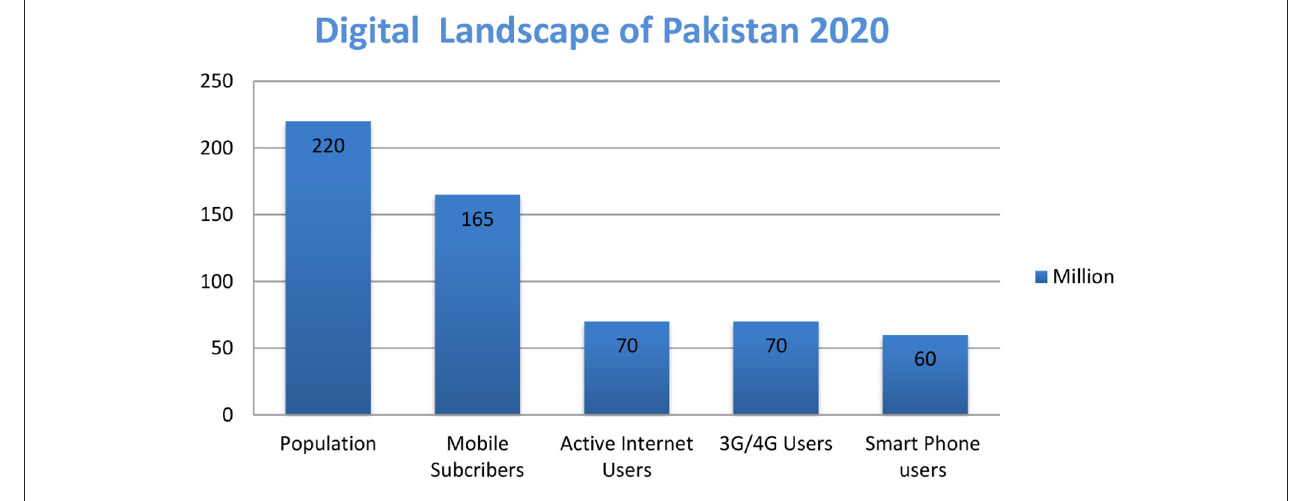
FIGURE 1 | Digital landscape of Pakistan 2020.